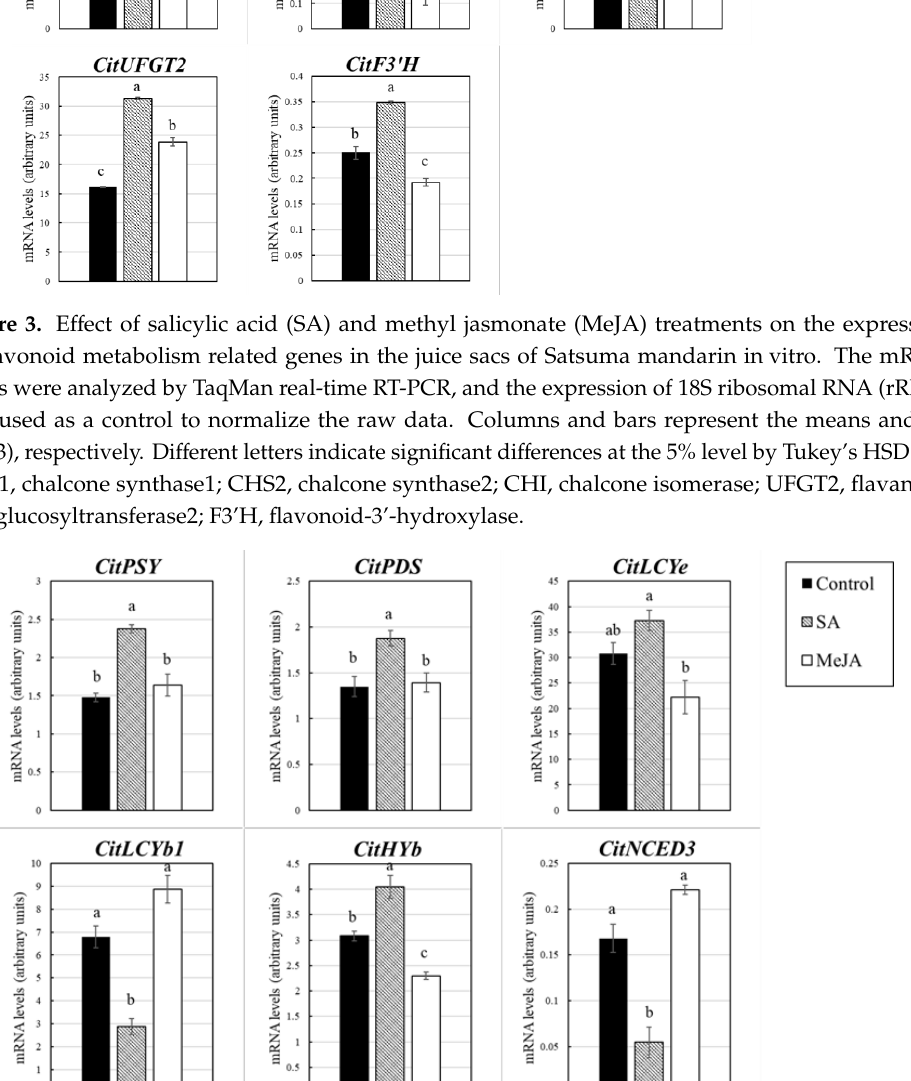
Table 1 . Details of three genes that were more than 2-fold upregulated in salicylic acid (SA) treatment and 2-fold downregulated in methyl jasmonate (MeJA) treatment. CNT, control.